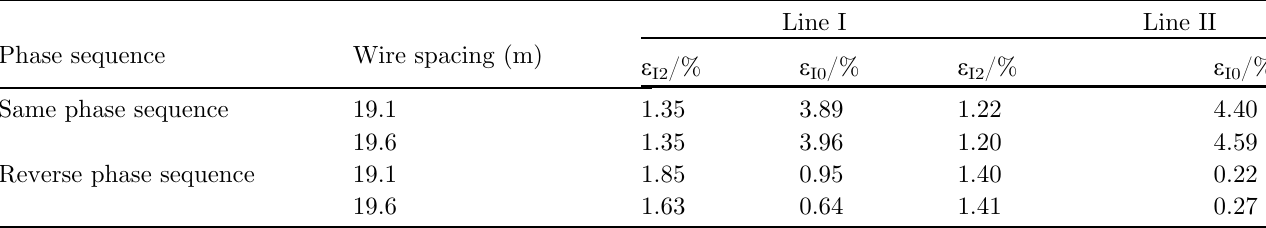
Table 6. In fl uence of distance between conductors on current unbalance. Phase sequence